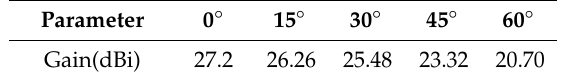
Table 1. Far-field performance for di ff erent orbital angular momentum (OAM) scanned